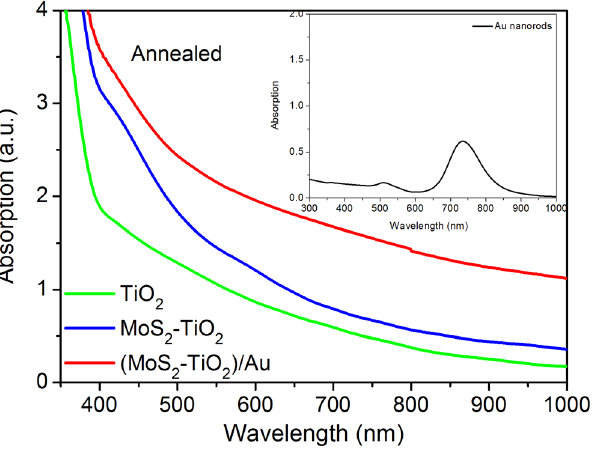
Figure 4. Absorption spectra of pure TiO 2 , MoS 2 -TiO 2 , and (MoS 2 -TiO 2 )/Au. The inset shows the absorption spectrum of as-prepared AuNRs.